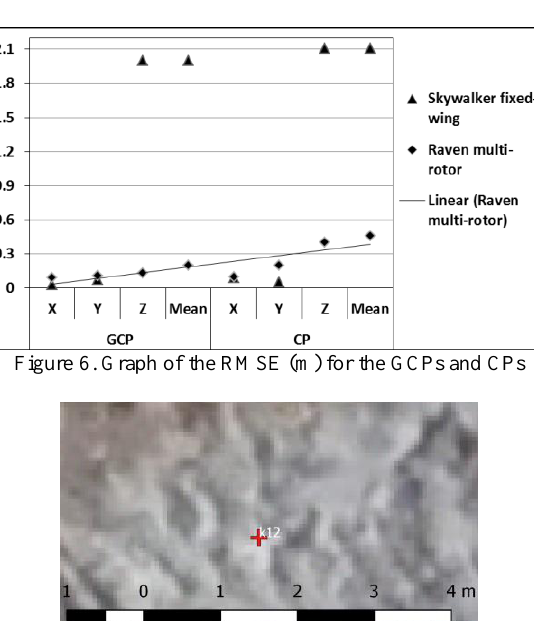
Table 4. RMSE for the ground control and check points.